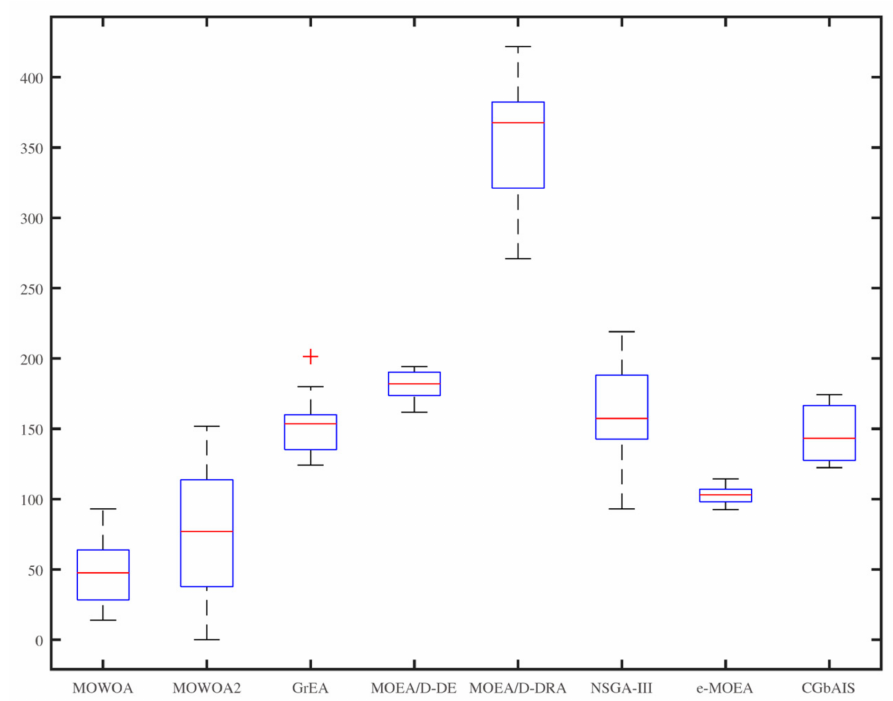
Figure 6. Energy consumption of the different algorithms when the user number is